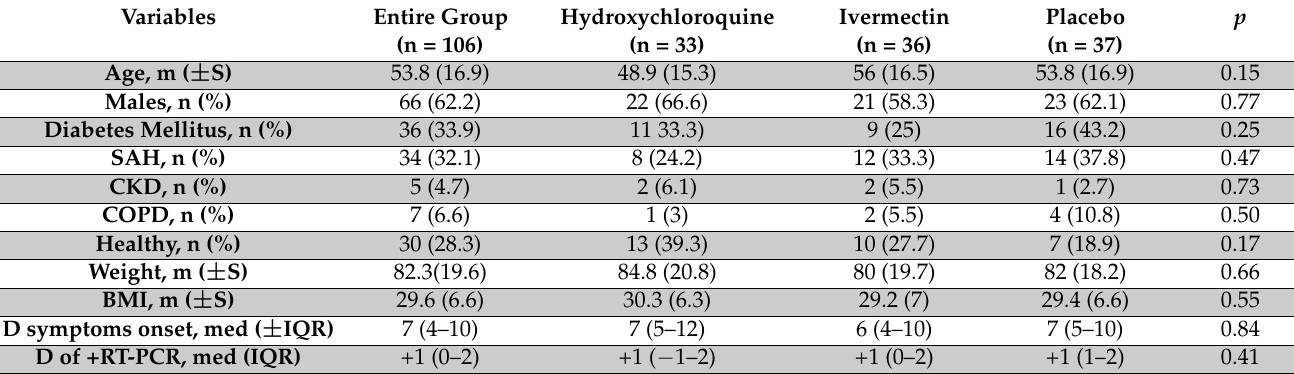
Table 1. Population characteristics.